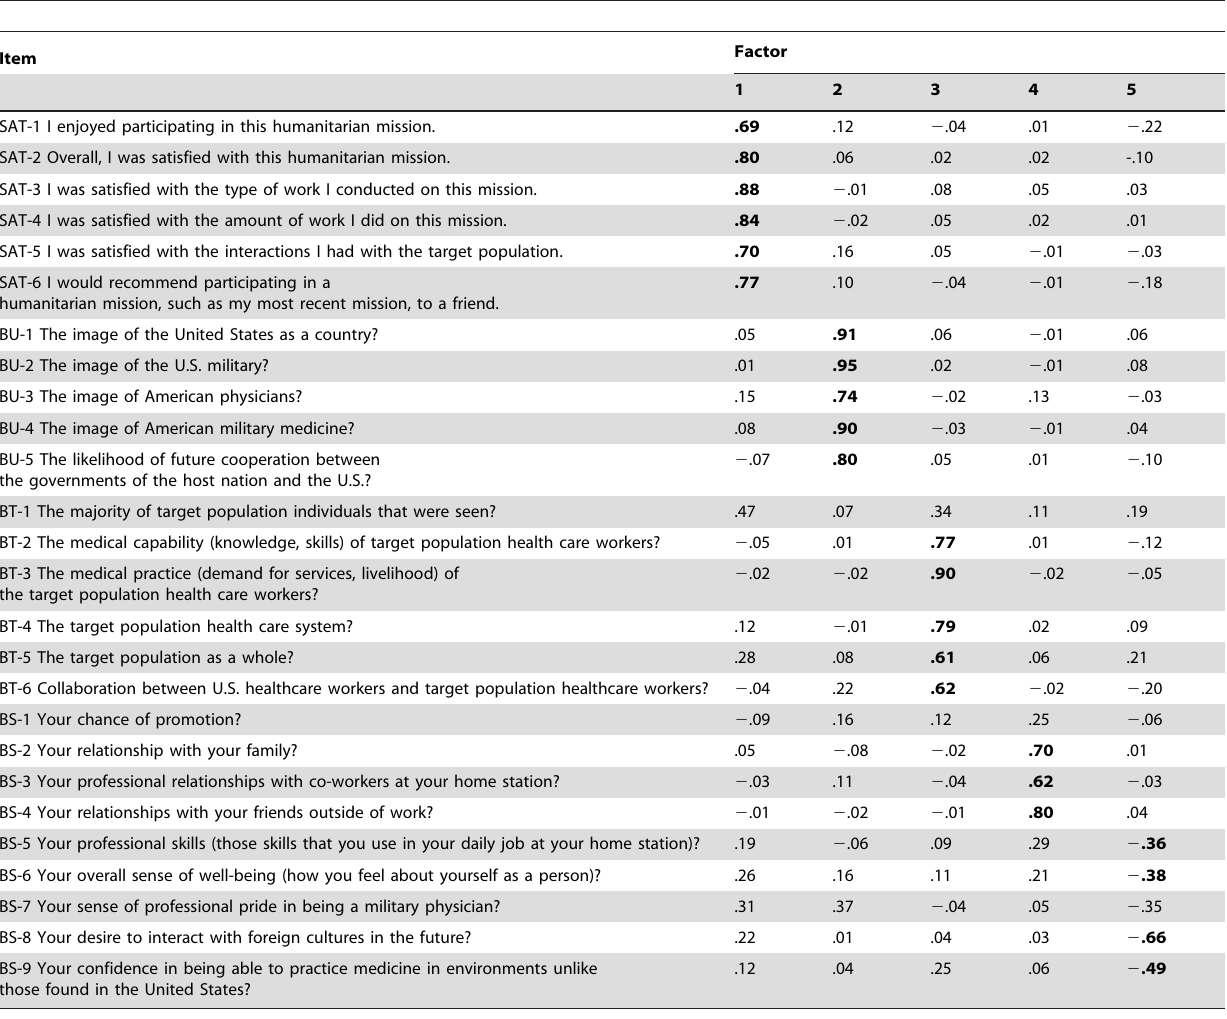
Table 2. Results (pattern coefficients) from the EFA with Oblique Rotation (Oblimin; delta =0) on the 26 survey items ( N =308).